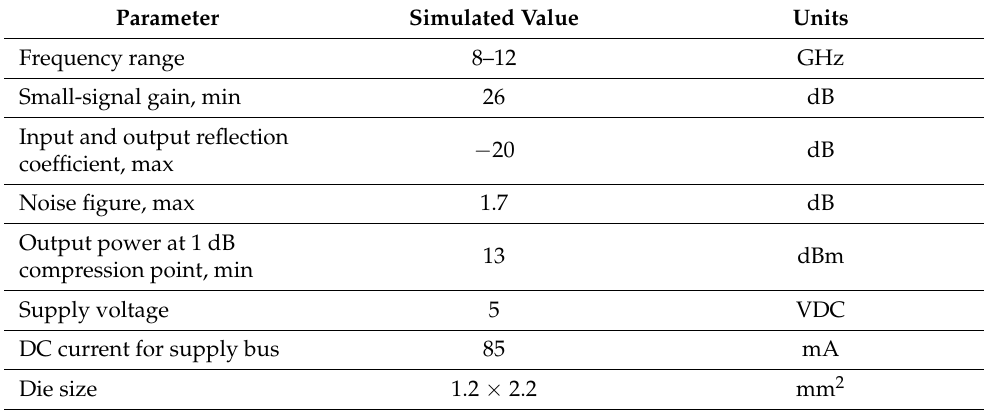
Table 3. The main parameters of the three-stage LNA developed using the first release of PDK.